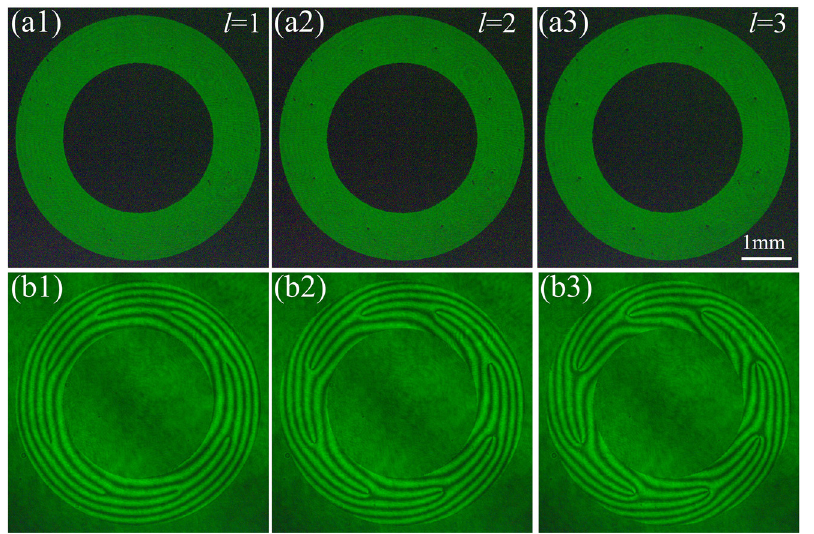
Figure 4: Interferograms of HO-OVL and a spherical